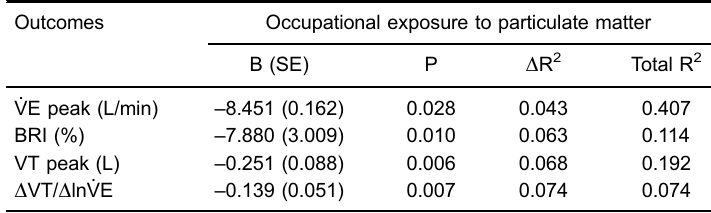
Table 4. Signi fi cant associations between occupational exposure to particulate matter and responses obtained in the cardiopulmonary exercise